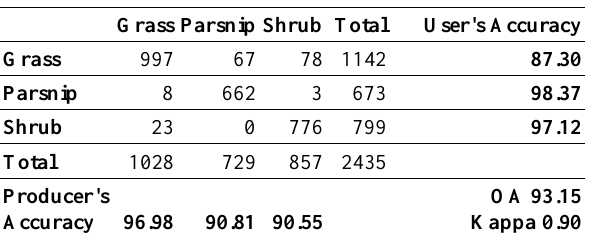
Table 5. Error matrix for accuracy assessment at Image Resolution 0.05 m.